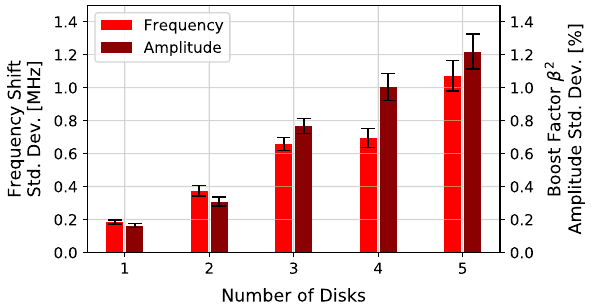
Fig. 12 Standard deviation on frequency position (left bars, light red) andstandarddeviationonamplituderelativetotheidealamplitude(right bars, dark red) of the boost factor after fitting the model to the measured group delays corresponding to the physical disk positions for one to five disks. More details cf.